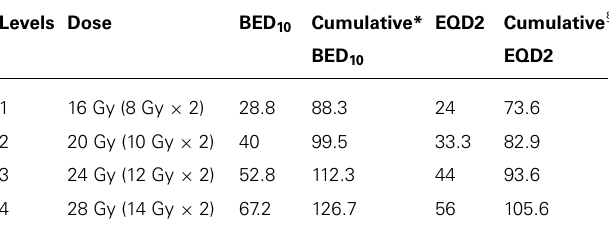
Table 4 | Biological equivalent dose (BED) and equivalent dose in 2 Gy per fraction (EQD2) for tumor control at each dose